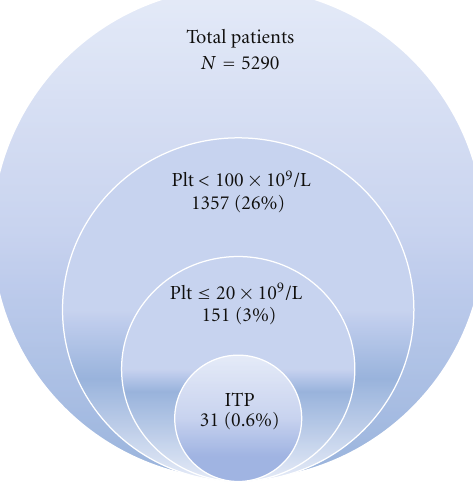
Figure 1: Incidence of thrombocytopenia in HIV-infected individ- uals in the HAART